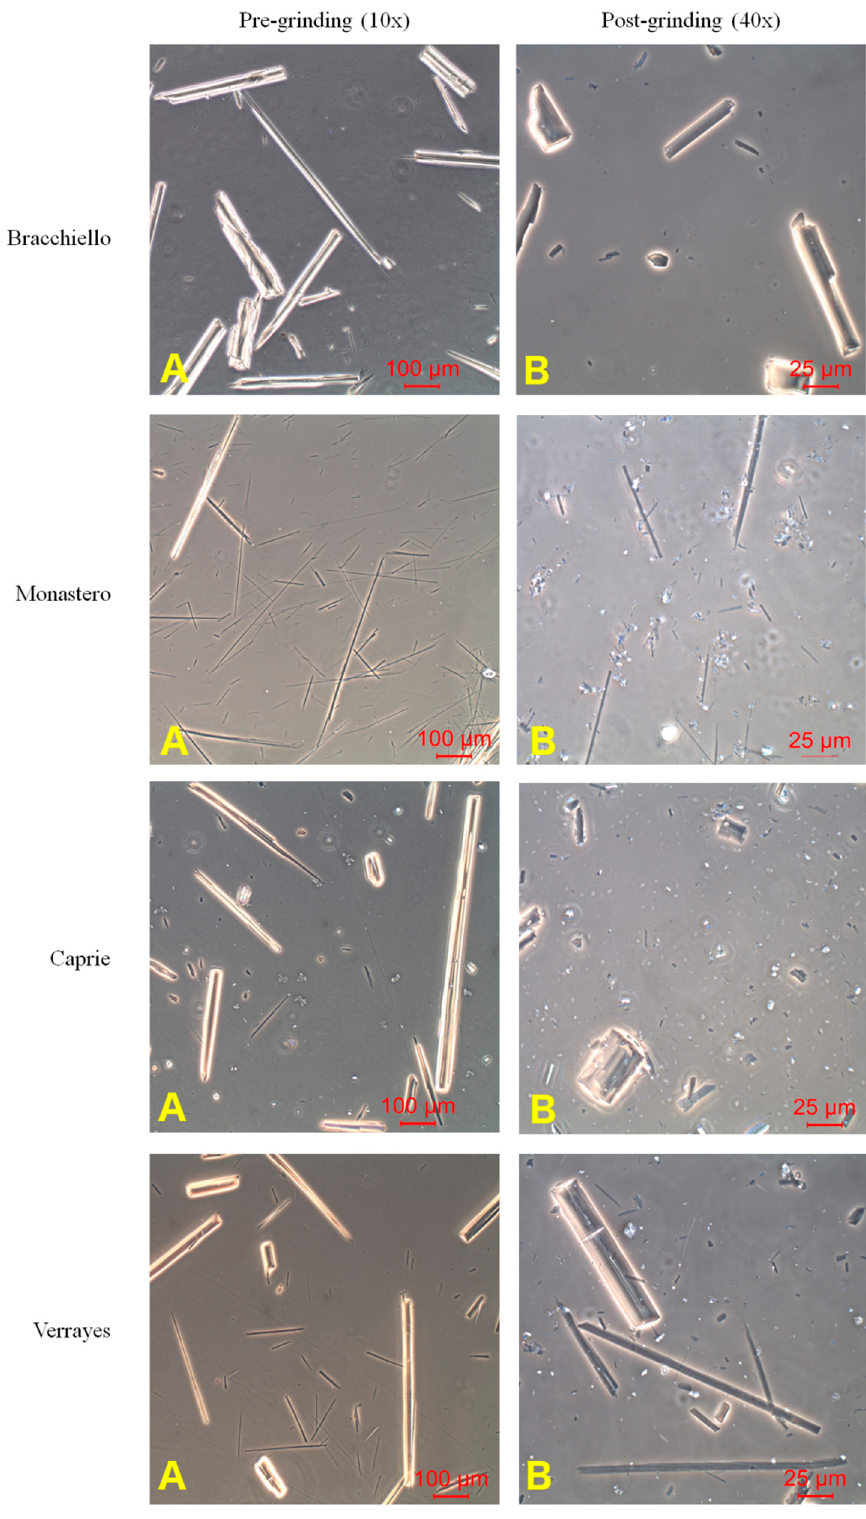
Figure 7. PCOM images ( A ) before and ( B ) after grinding.